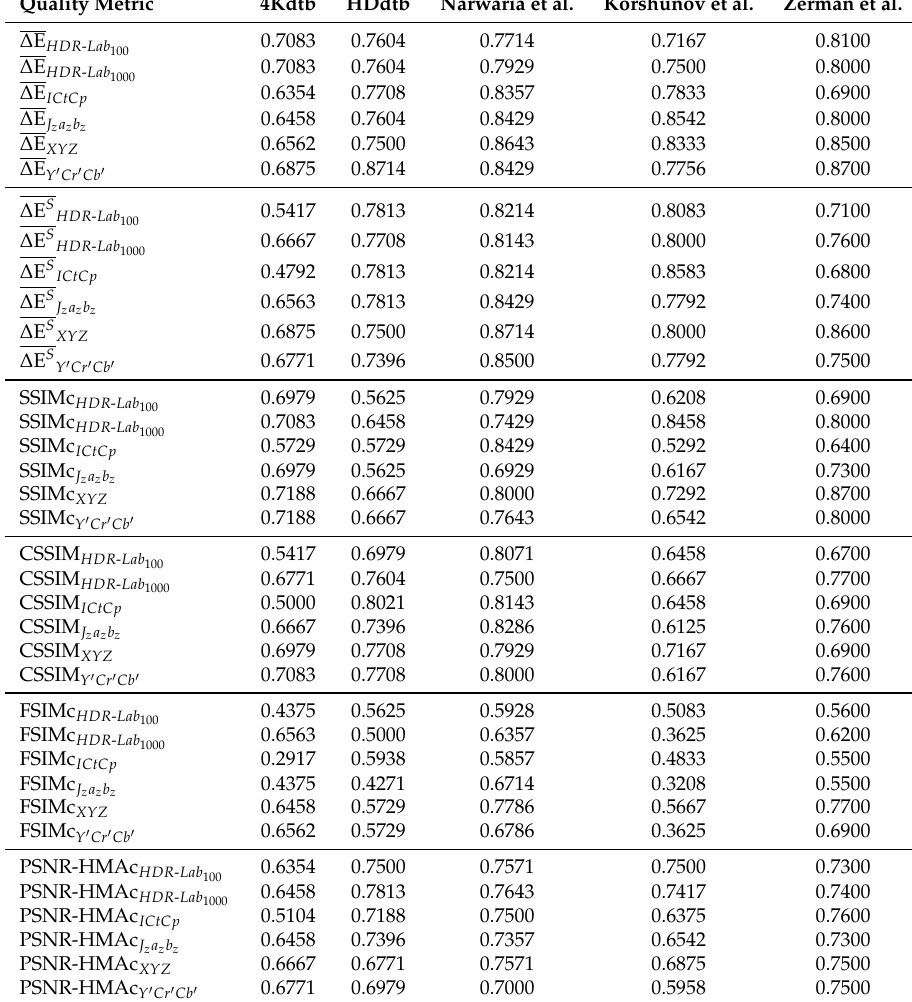
Table A6. OR of the different color quality metrics on the considered